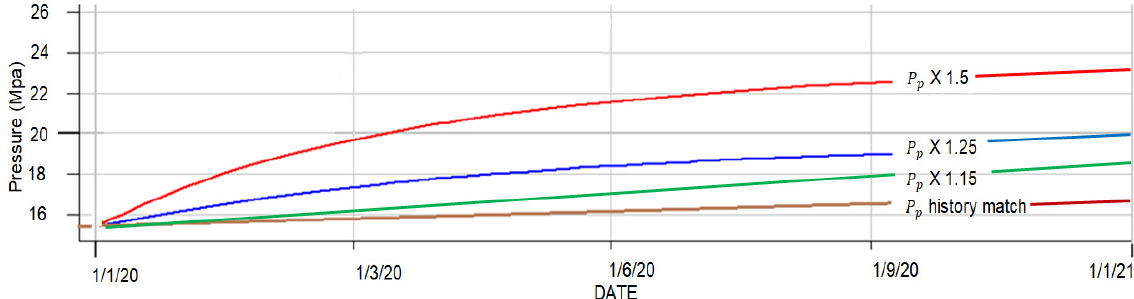
Figure 14. Pressure pro fi les for the history matching scenario and scenarios multiplied by fi xed factors ( 𝑃 (cid:3043) , 𝑃 (cid:3043) X 1.15, 𝑃 (cid:3043) X 1.25, and 𝑃 (cid:3043) X 1.5) controlled by gas injection rates until fault reactivation occurs.